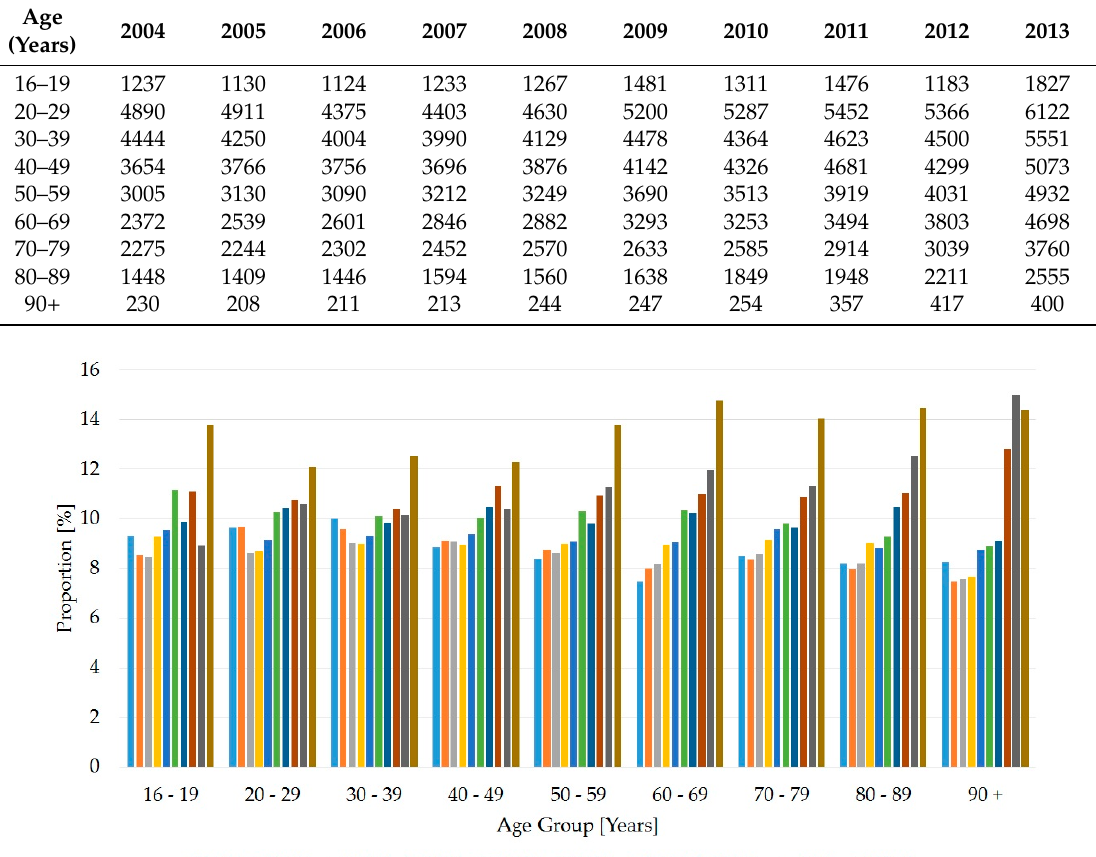
Figure 3. Percentage distribution of age groups (years), by year ( N = 264,272 persons).